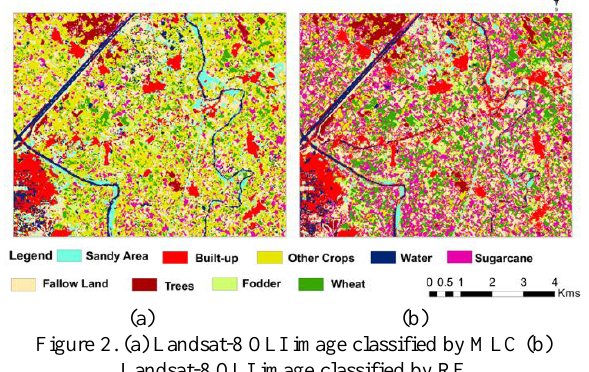
Figure 2. (a) Landsat-8 OLI image classified by MLC (b) Landsat-8 OLI image classified by RF